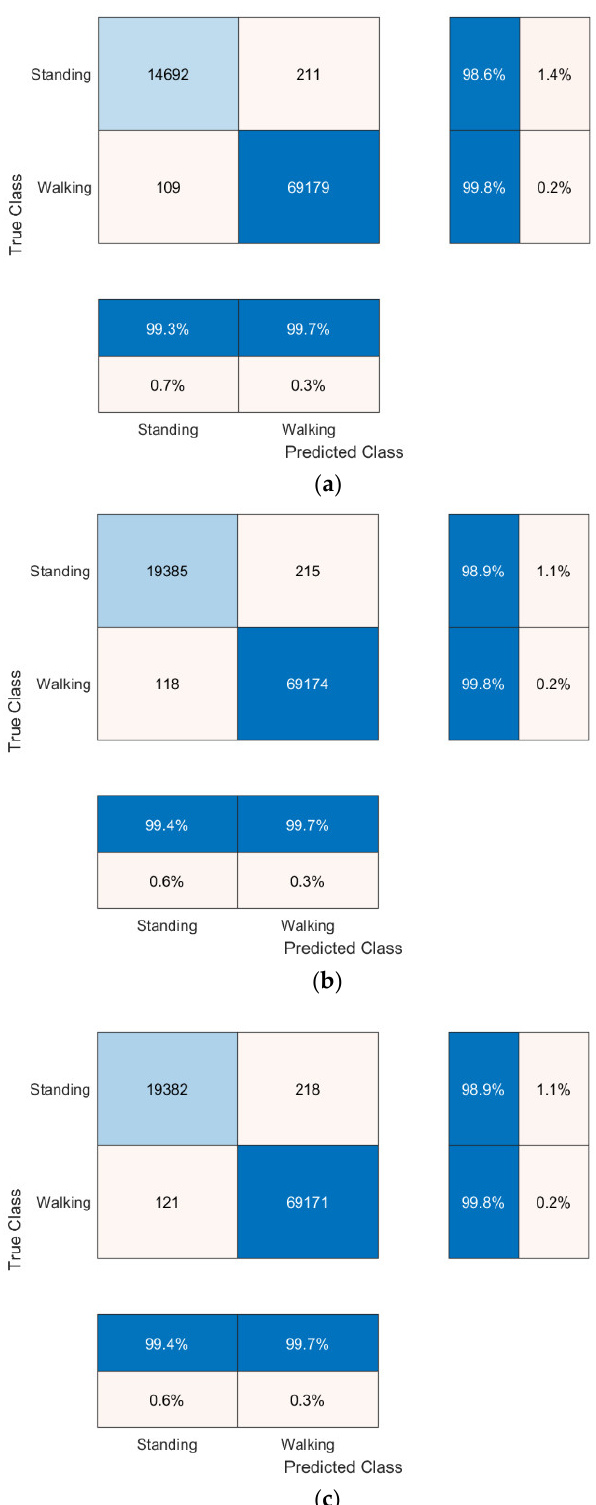
6, are shown in Figure 1a–c, respectively.